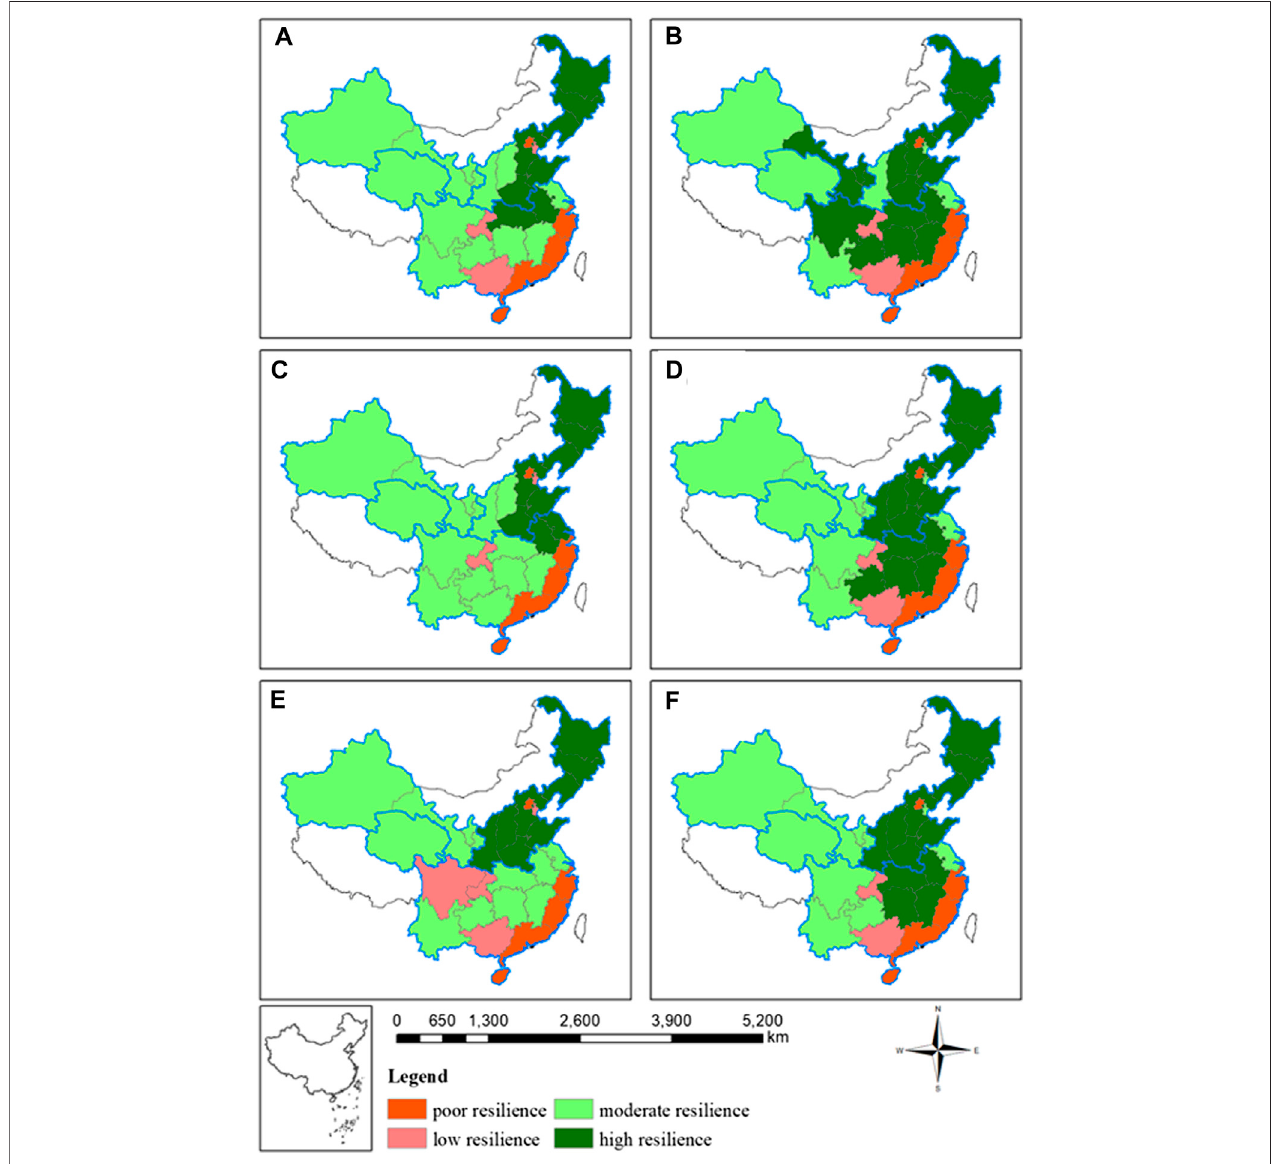
FIGURE 5 | Resilience assessment for grain output per person under different scenarios; (A) 2035 SSP1 – 2.6, (B) 2050 SSP1 – 2.6, (C) 2035 SSP2 – 4.5, (D) 2050 SSP2 – 4.5, (E) 2035 SSP5 – 8.5, (F) 2050 SSP5 – 8.5.